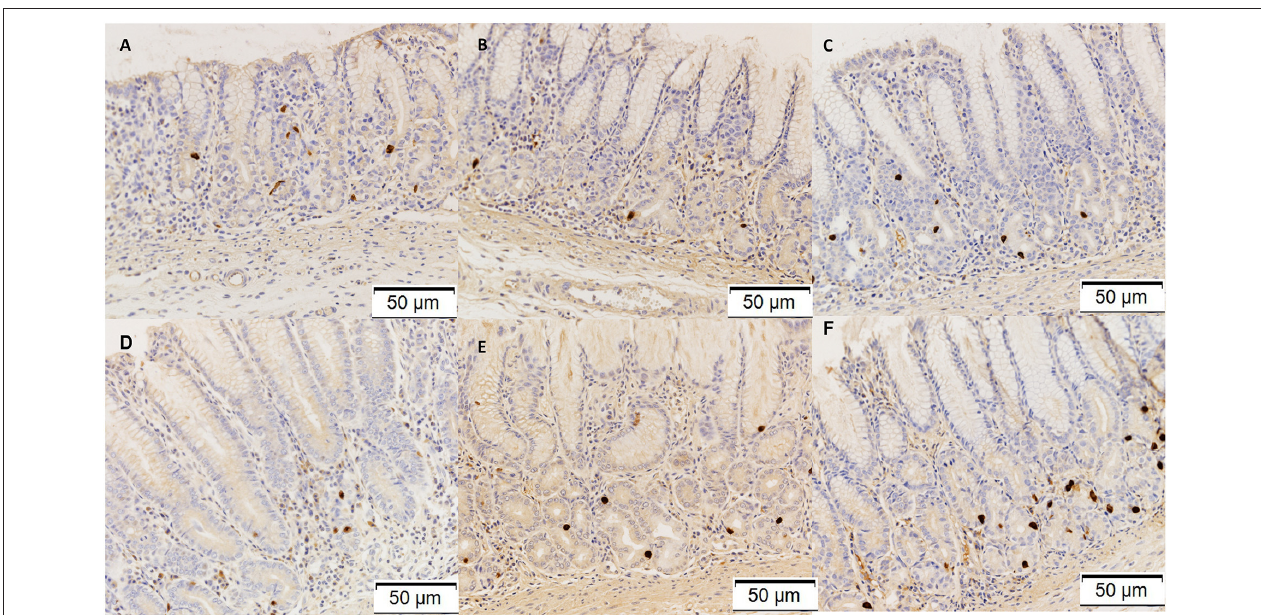
FIGURE 3 | Representative immunohistochemistry staining for ghrelin (brown) in the fundus in post-weaned pigs fed without or with pharmacological zinc and copper. Images (A–C) represents day 7 and (D–F) represents day 21 post weaned stomach samples. Pigs were fed a control diet in both phases [CON, images (A,D) ]. Images (B,E) are stomach sections from pigs were fed pharmacological zinc and copper in phase 1, and a control diet in phase 2 (ZC-CON). Pigs were fed pharmacological zinc and copper in both phases (ZC) are represented in images (C,F) .